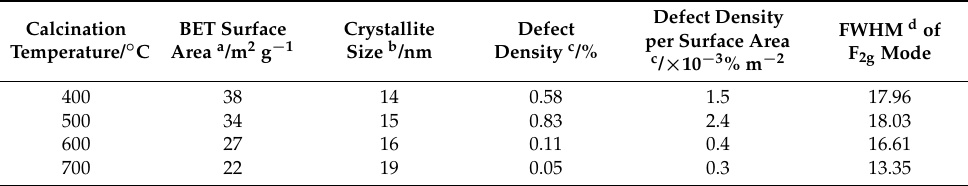
Figure 3. Powder XRD pattern of CeO 2 calcined at different temperatures (400–700 °C); reflections match the cubic fluorite structure of ceria (Fm-3m). Table 3. Textural properties of CeO 2 catalysts calcined at different temperatures.